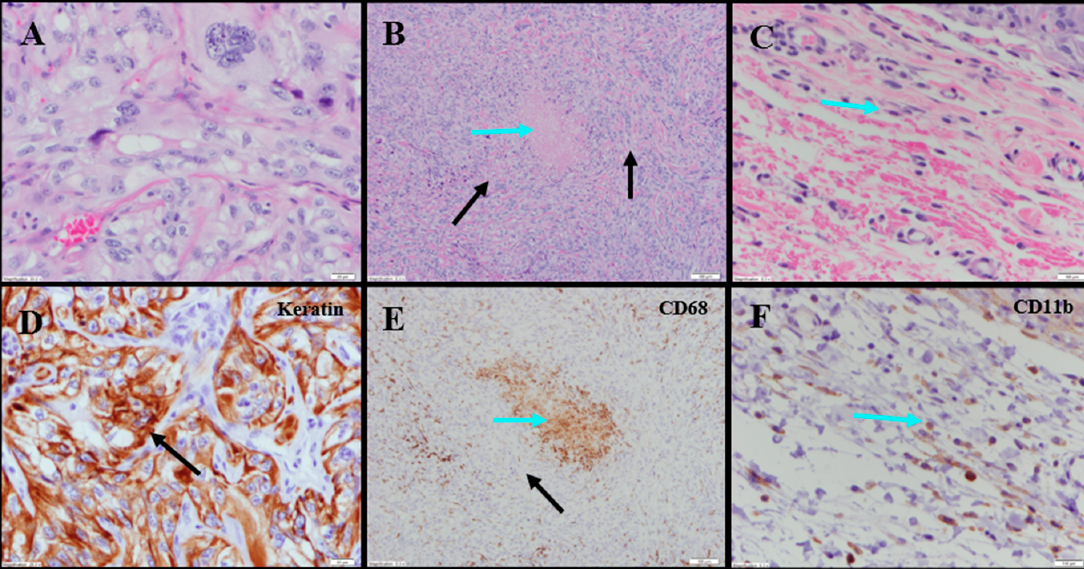
Figure 3. Representative photomicrographs of untreated renal tumors. ( A ) Cohesive tumor cells (TCs) 40 × . ( B ) Same animal as panel ( A ): Central focus of necrosis is sharply demarcated from the surrounding viable TCs (black arrows), and is composed of amorphous material (blue arrow) 10 × . ( C ) Same animal as panel ( A ): Limited, small peritumoral lymphocytes (blue arrow) 10 × (cropped). ( D ) Same tumor section as panel ( A ): anti-AE1 / AE3 was sensitive and specific for TCs (black arrow) 40 × . ( E ) Same tumor section as panel ( B ): anti-CD68 shows limited macrophages (M φ ) among viable TCs (black arrow) and markedly increased M φ in the focus of necrosis (blue arrow) 10 × . ( F ) Same tumor section as panel ( C ): peritumoral CD11b + lymphoid cells (blue arrow) 10 ×